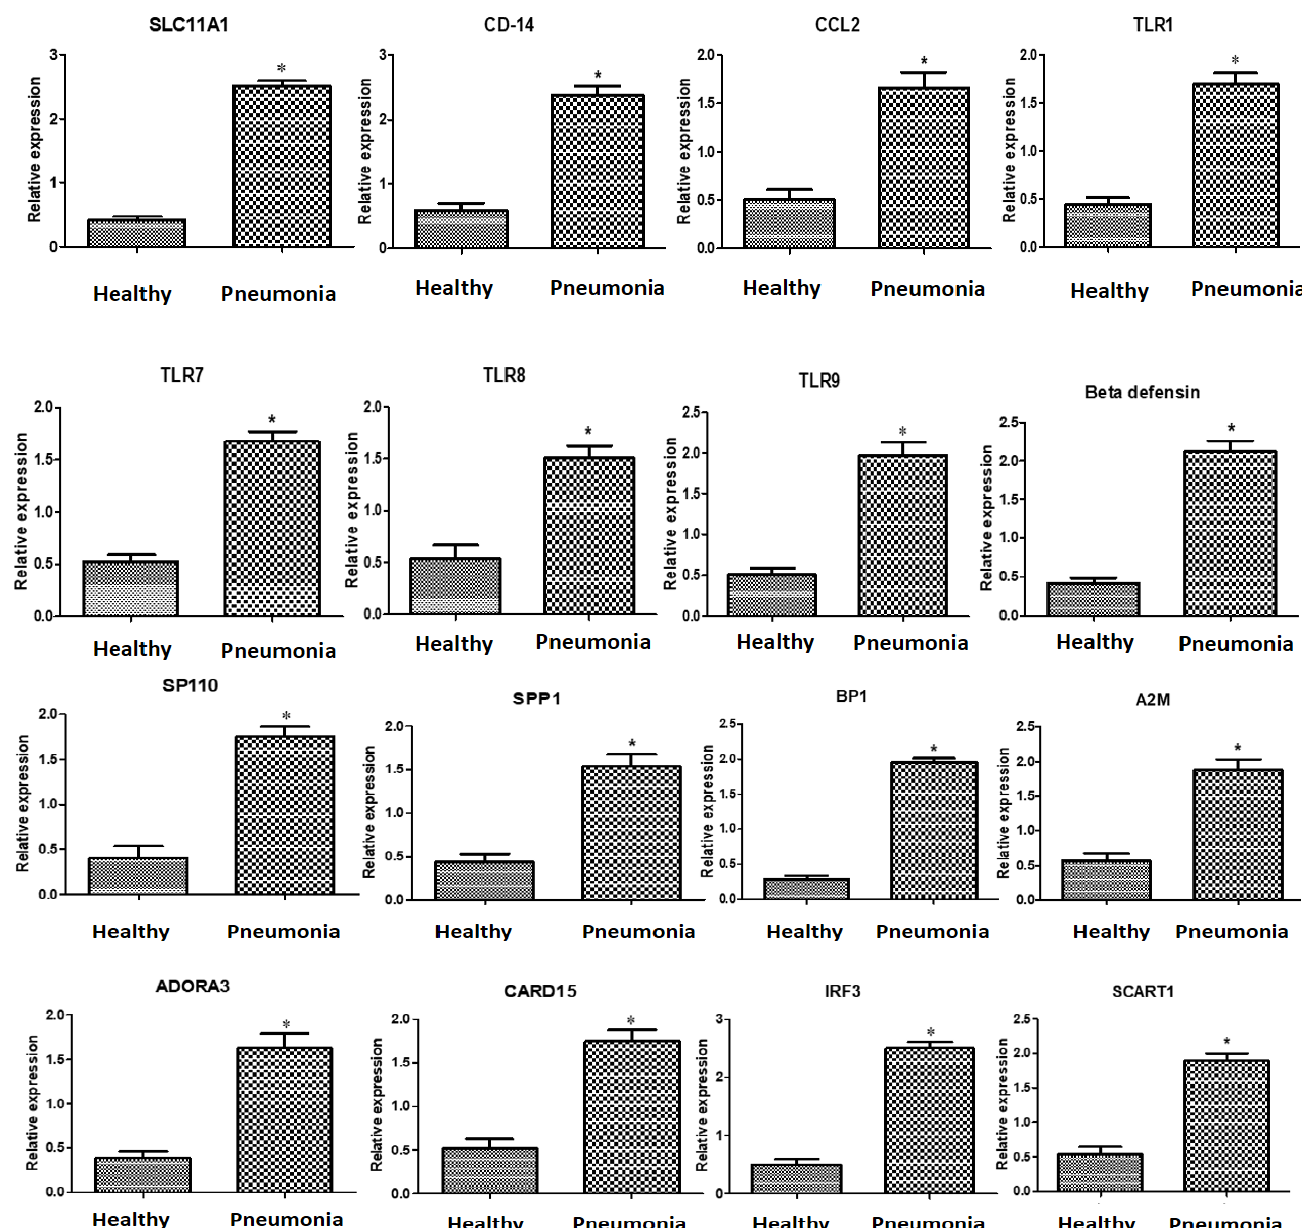
Figure 1. SLC11A1 , CD-14 , CCL2 , TLR1 , TLR7 , TLR8 , TLR9 , β defensin , SP110 , SPP1 , BP1 , A2M , ADORA3 , CARD15 , IRF3 , and SCART1 gene expression comparisons in healthy and pneumonic Baladi goats. * indicates significance when p < 0.05.